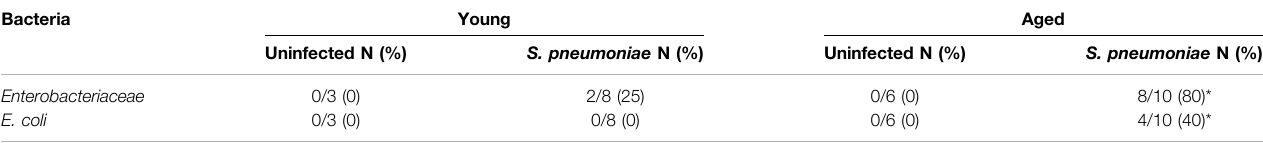
TABLE 1 | Number of mice positive for Enterbacteriaceae and E. coli DNA in the lungs 24 h after infection. (%) *p < 0.05 compared to young S. pneumoniae infected mice by Pearson ’ s chi-squared test.